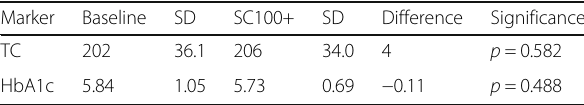
Table 2 SC100+ lowers key marker of stress and trends